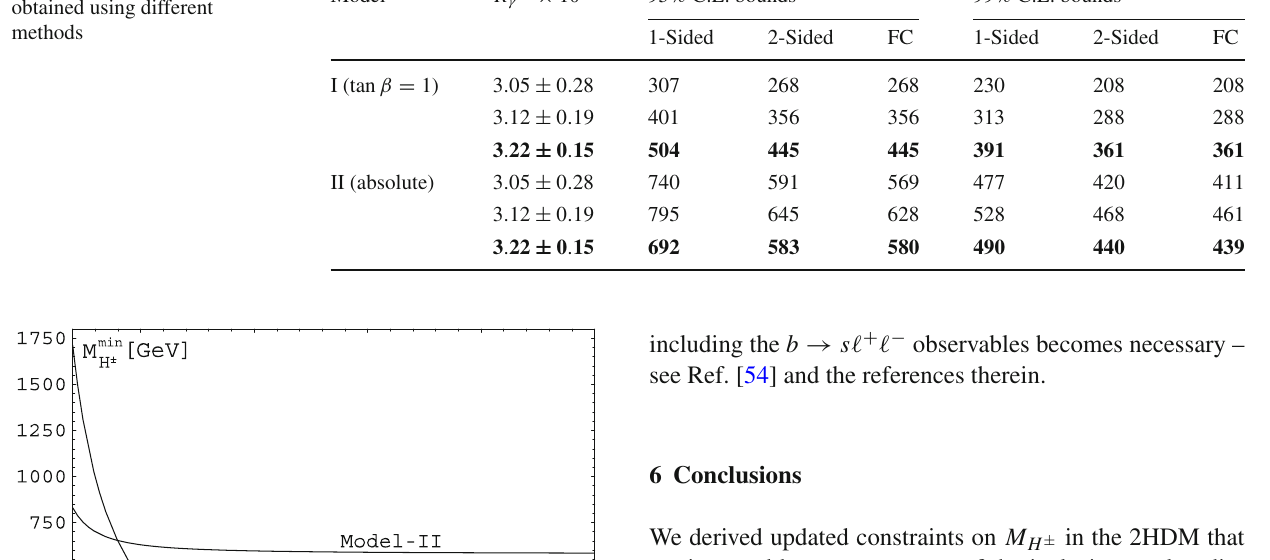
Table 3 Bounds on M H ± obtained using different methods